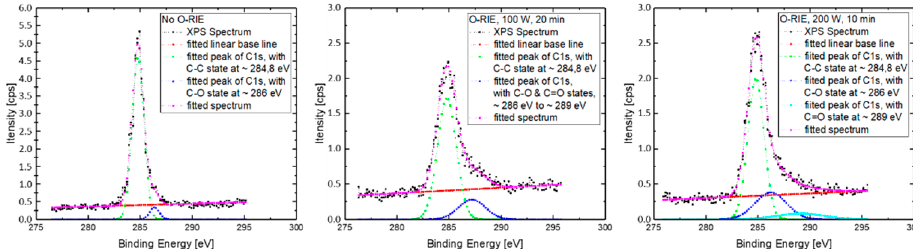
Figure 10. XPS batch scan spectra about C 1s area, respectively, for sample surfaces without O-RIE (left), with 100 W O-RIE (middle), and 200 W O-RIE (right) processes.